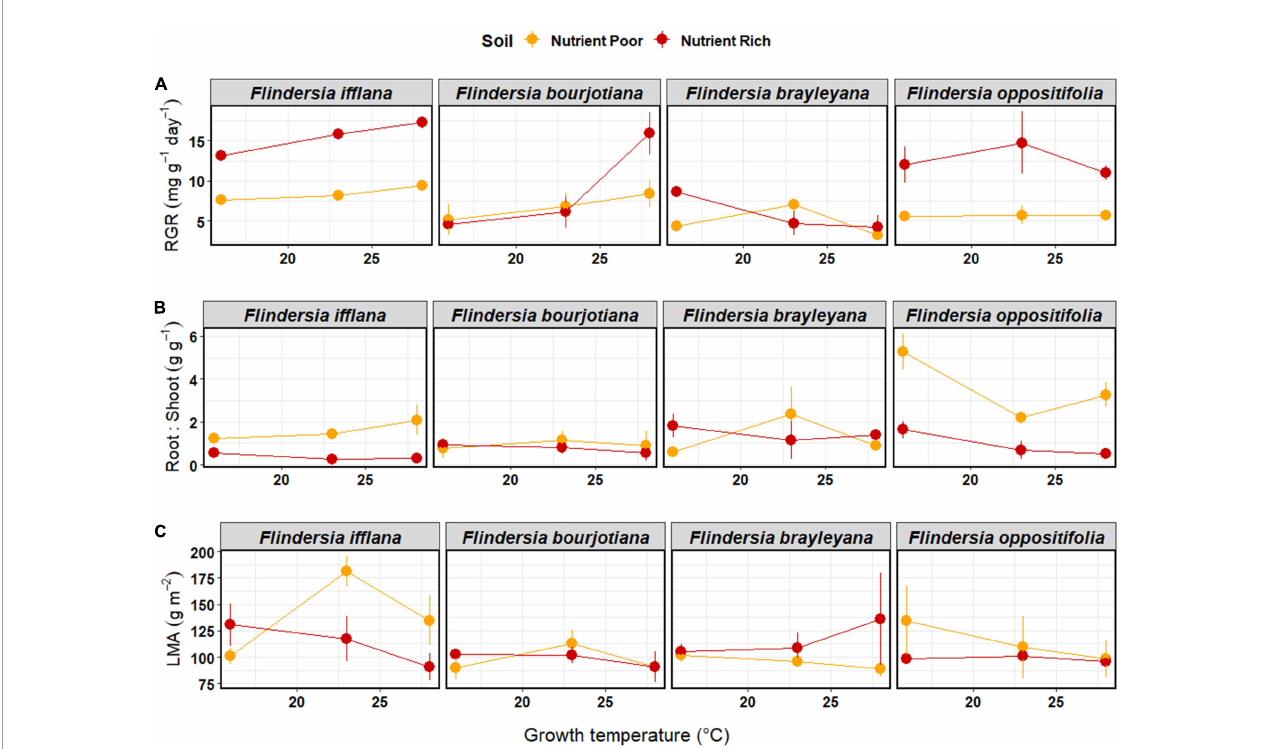
FIGURE3 Means ( ± 1SE) of (A) relative growth rate (mg g − 1 day − 1 ), (B) root-to-shoot ratio (g g − 1 ), and (C) leaf mass per unit area (g m − 2 ) among temperature and soil nutrient treatments (nutrient-rich soil = red, nutrient-poor soil = orange) in the glasshouse experiment. Each dot represents a mean of three individual saplings. Species are arranged left to right according to their observed elevation ranges, with leftmost being lowland and rightmost being